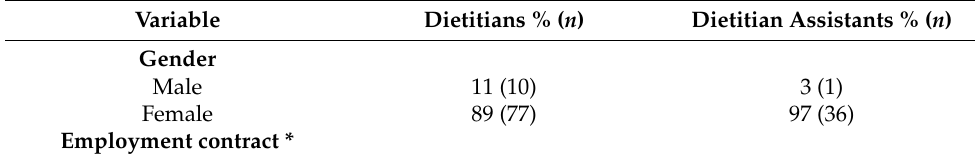
Table 2. Demographics of dietitians ( n = 87) and dietitian assistants ( n = 37)